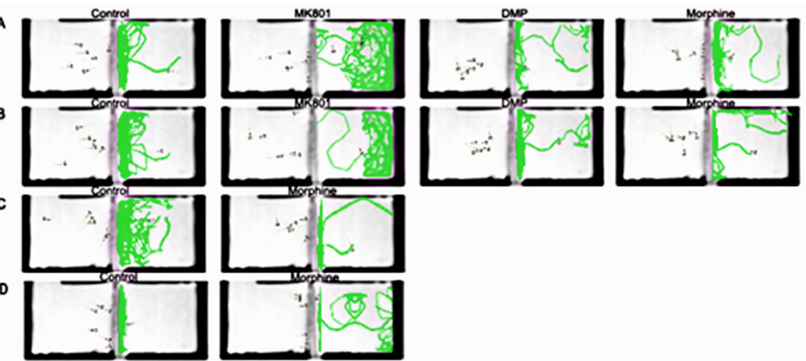
Figure 4. Tracked trajectories for control, MK801, DMP and morphine treated larvae after being subjected to conspecific larvae. Effects of ( A ) short-term and ( B ) long-term exposure to MK801, DMP and morphine, and after withdrawal of ( C ) short-term and ( D ) long-term morphine treatment on the social preference. Drug abbreviation: DMP, domperidone. Dopaminergic neurons were seen distributed in brain regions mainly in the periventricular nucleus of posterior tubercule (TPp), posterior tuberculum (PT), caudal hypothalamus (Hc), and locus coeruleus (LC). A noticeable increase was seen in the dis- tribution of dopaminergic neurons, especially in the PT region, between the control and the drug-treated larvae (Figure 5A,B). Exposure to drugs, particularly MK801, was asso- ciated with a significant increment of dopaminergic cell number (Figure 6A,B). Nonethe- less, during the morphine withdrawal, there was no significant difference in the number of dopaminergic neurons between the control and the morphine treated group (Figures 5C,D and 6C,D). Histograms (Figure 7A,B) show that all treatments increased concentra- tion of DA, reflecting increment of dopaminergic cell number. However, DA levels re- mained high during morphine withdrawal (Figure 7C,D).